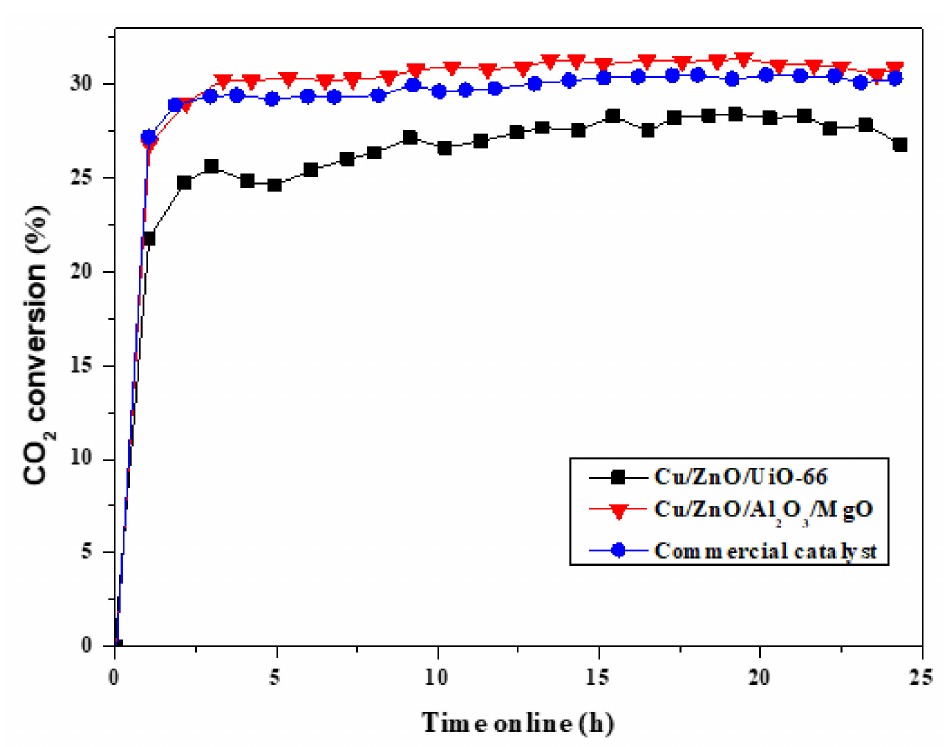
Figure 6. CO 2 conversions of catalysts. T = 230 ◦ C; P = 50 bar; Qv, 0 = 40 mL · min − 1 ; GHSV = 10,000 h − 1